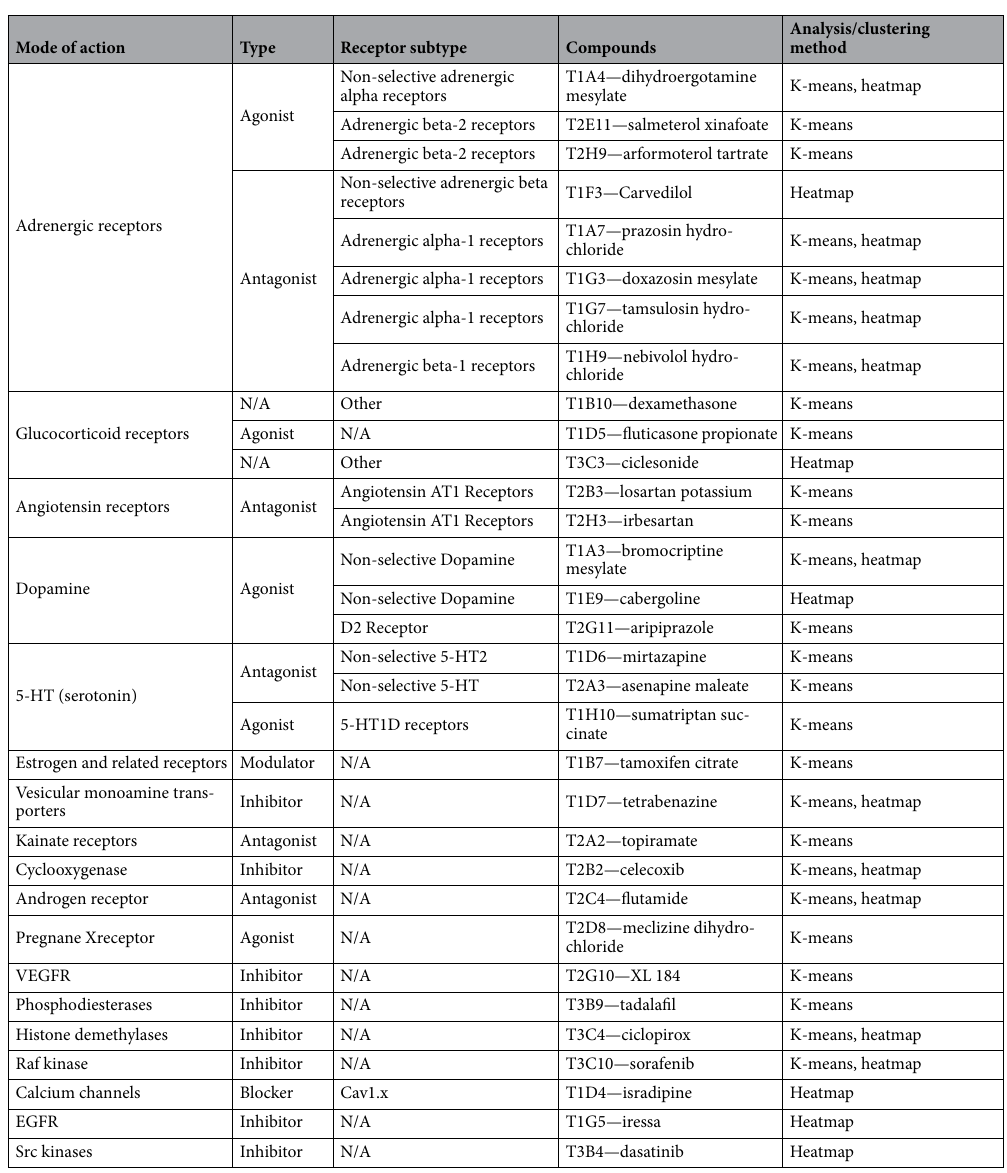
Table 2. List of the drugs showing CsA-like behavioral profiles identified using K-means and hierarchical clustering. K-means and heatmap analysis identified a range of drugs known to act on various molecular targets. The table describes in detail the main target receptor type and subtype the drug acts on and its pharmacological mode of action (agonist or